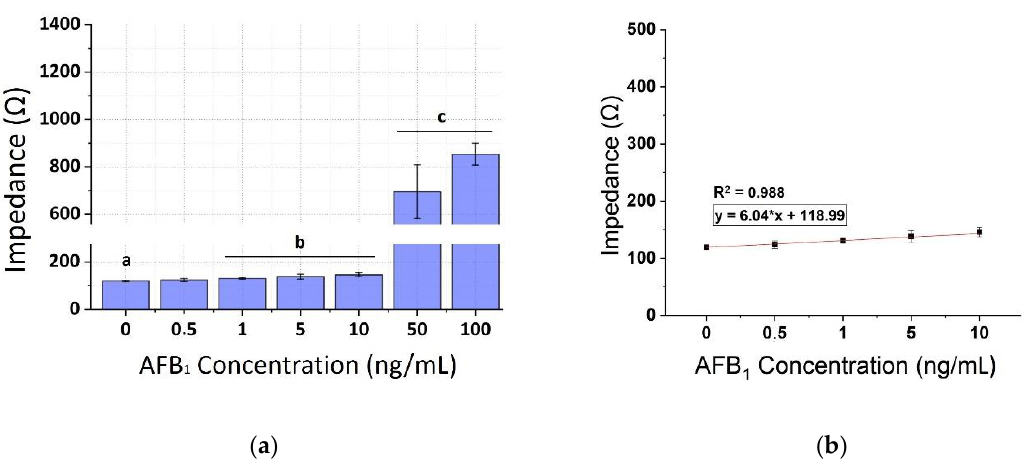
Figure 7. ( a ) Extracted results from the mean impedance magnitude values for di ff erent concentrations of AFB 1 standard solutions tested at 10 KHz ± STD. Di ff erent letters (a, b, c) indicate statistically significant di ff erent values ( p < 0.05). ( b ) Linear fit curve of the values of the mean impedance magnitude for concentrations of AFB 1 standard (0–10 ng / mL) tested at 10 KHz.